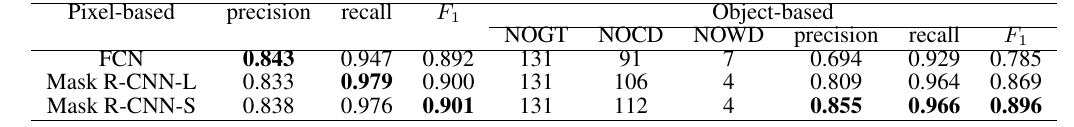
Table 1. Quantitatively building segmentation result in ISPRS. (NOGT: number of objects (ground truth); NOCD: number of objects correctly detected; NOWD: number of objects wrongly detected). Mask R-CNN-L: Mask R-CNN